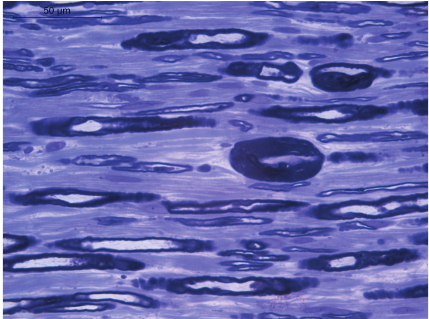
Figure 1: Longitudinal section of sural nerve biopsy showing two myelin outfoldings (tomacula). Toluidine blue